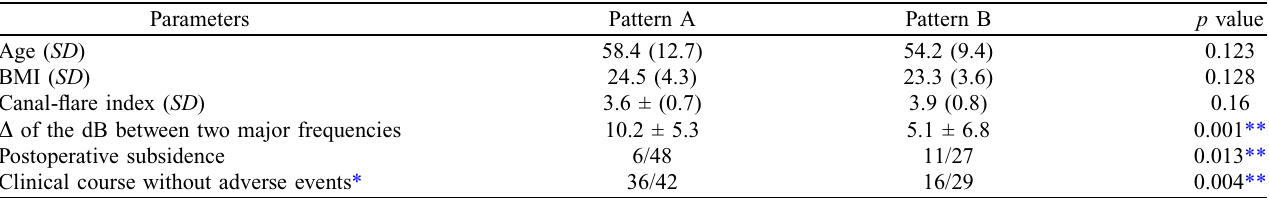
Table 1. Sound data analysis showed that pattern A had a significantly greater difference in peak value between the two major frequencies than Pattern B. Pattern A could predict good clinical